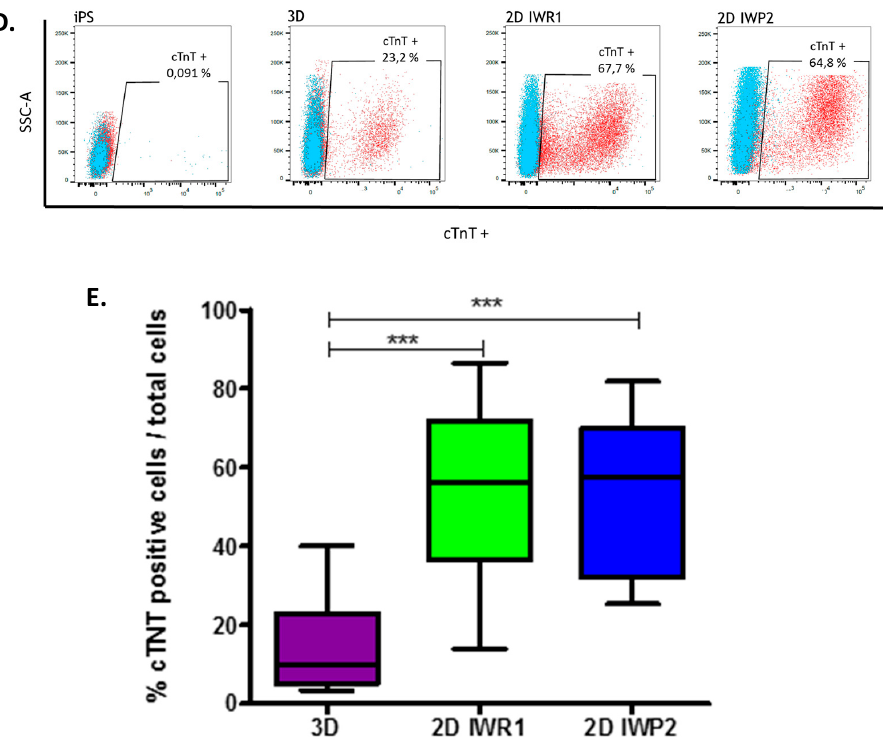
Figure 1. Comparison of protocols. ( A ) Schematic representation of differentiation protocols; blebbistin = blebbistatin ( B ) Schematic overview of the canonical Wnt pathway and the targets of the Wnt inhibitors used; ( C ) Aspect of differentiated iPSCs on day 30 in transmitted light; ( D ) Troponin expression at day 27 ± 2 analyzed by flow cytometry. Typical flow cytometry plots show negative IgG control in blue and cTnT+ cells in red ( E ) Quantification (box-whisker plots showing minimum, first quartile, median, third quartile and maximum) of cardiac troponin T expression measured by flow cytometry in the three compared protocols from 11 to 16 differentiations with 3 different clones. *** p < 0.001.